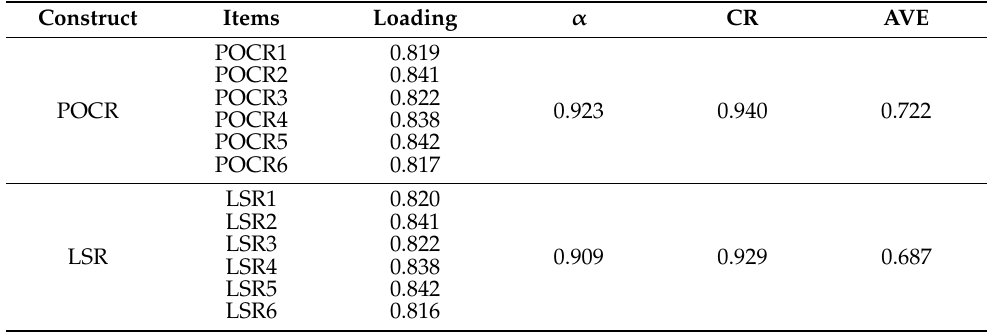
Table 2. Reliability and validity